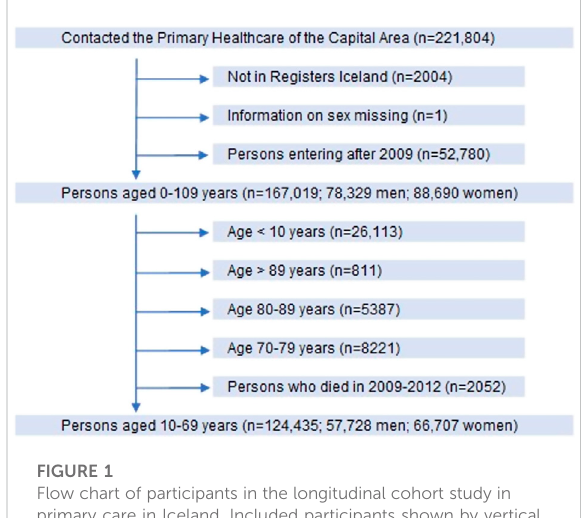
FIGURE 1 Flow chart of participants in the longitudinal cohort study in primary care in Iceland. Included participants shown by vertical arrows and those excluded by horizontal